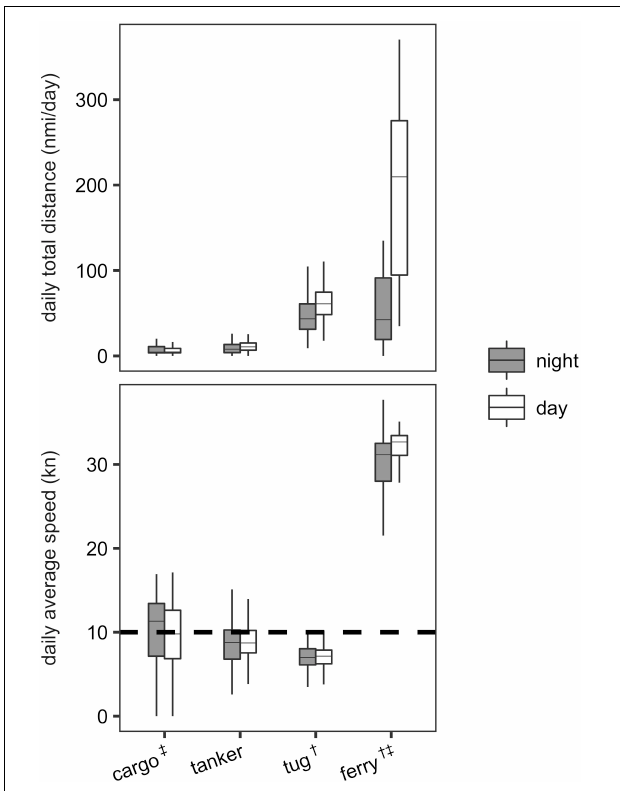
FIGURE 5 | Daily distance (nmi/day) (top) and average speed (kn) (bottom) by day/night for each vessel class using exclusively AIS data. Box and whisker plots show sample minimum, maximum, median, and first and third interquartile values. Outliers are not shown. Statistically significant differences in median daily distance between day/night denoted by † ( p < 0.01). Statistically significant differences in median speed between seasons denoted by ‡ ( p < 0.01). Dashed line indicates 10-kn voluntary speed restriction used in National Marine Sanctuaries outside San Francisco Bay (United States Coast Guard [USCG], 2017). Sample sizes: n 1 = 175 days (day), n 2 = 175 days (night).